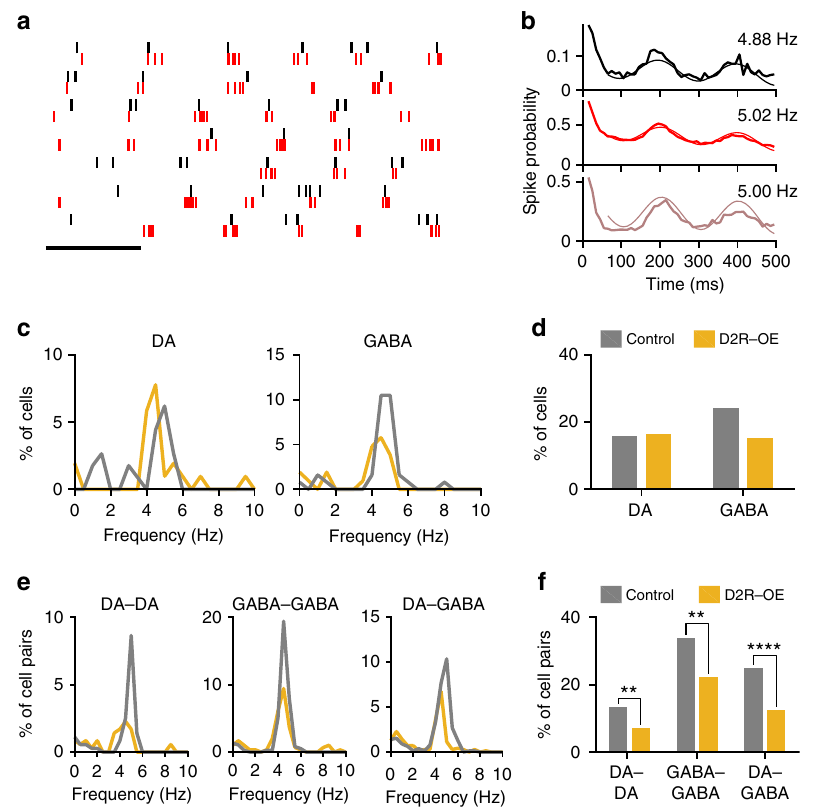
Fig. 5 Disrupted coordination of rhythmic 4 Hz fi ring patterns in the VTA of D2R-OE mice. a Spikes of two simultaneously recorded VTA neurons, (red and black), during performance of the WM task. Each row corresponds to a single sample or choice run, aligned to run onset. Note the presence of coordinated rhythmic fi ring patterns in the two neurons. Scale bar: 250 ms. b Autocorrelograms of the two neurons in ( a ) (top, middle) and their cross-correlogram (bottom). Thin line indicates the sinusoidal function that best fi t the correlograms and which was used to determine the presence of rhythmic fi ring and its frequency (inset; see Methods). c Distribution of frequencies at which rhythmic fi ring was observed in VTA DA and GABA neurons. Note the prevalence of fi ring patterns between 3 and 6 Hz, referred to here as “ 4 Hz ” fi ring. d The percentage of VTA DA (Control: n = 113; D2R-OE: n = 103) and GABA neurons (Control: n = 124; D2R-OE: n = 104) displaying rhythmic fi ring in the 4 Hz range. The proportion of neurons was the same in both genotypes for both VTA DA ( p = 1.00, Fisher ’ s exact test) and GABA neurons ( p = 0.1). e Distribution of frequencies at which VTA neuron pairs displayed rhythmic coordinated fi ring. f Proportion of DA-DA (Control: n = 358; D2R-OE: n = 352), GABA-GABA (Control: n = 376; D2R-OE: n = 296), and DA-GABA (Control: n = 780; D2R-OE: n = 696) cell pairs showing coordinated 4 Hz fi ring. The proportion of cell pairs showing rhythmic coordinated 4 Hz fi ring was lower in D2R-OE mice (** p < .01, **** p < .0001, Fisher ’ s exact